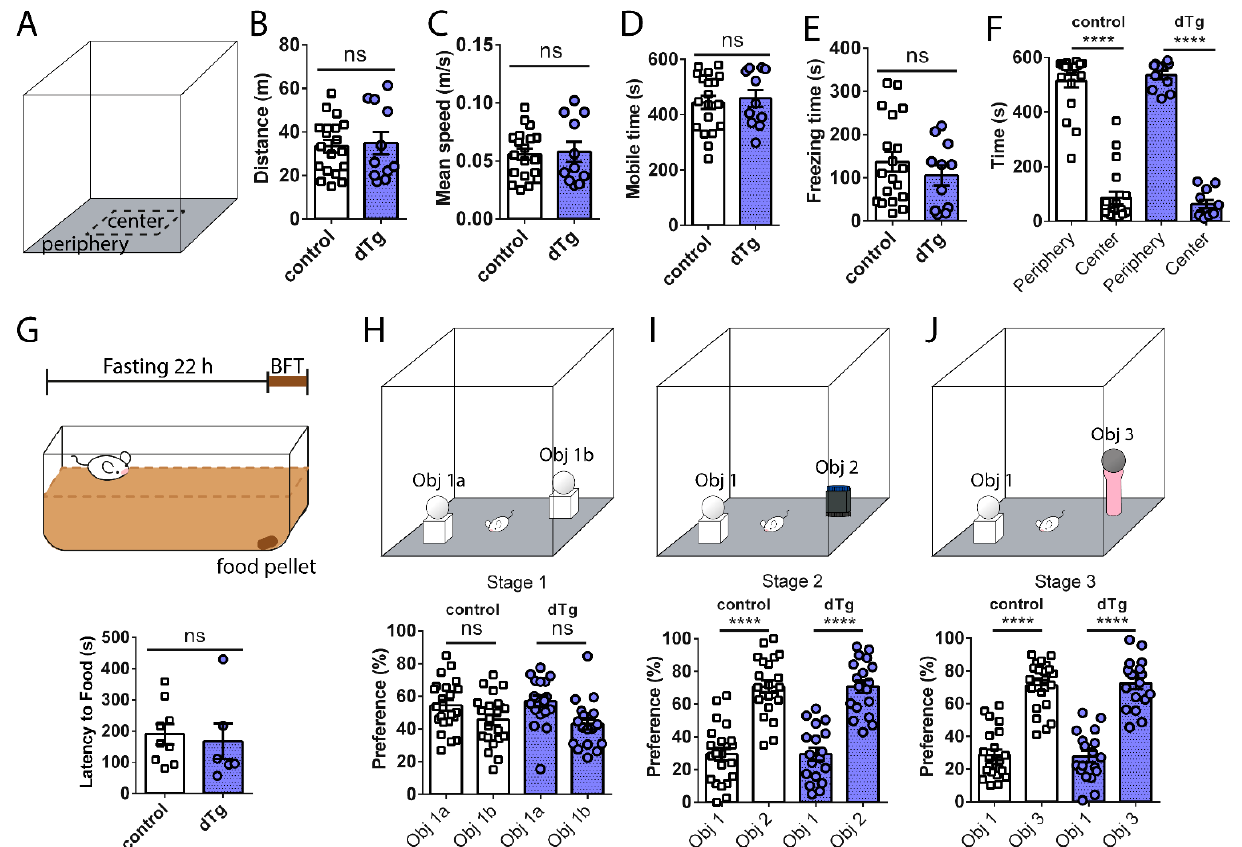
Figure 3. Normal locomotor activity, anxiety, and olfactory behavior in dTg animals. ( A ) Schematic of open field test. No differences between control and dTg mice in ( B ) distance (t (28) = 0.2464, p = 0.8072), ( C ) mean speed (t (28) = 0.2403, p = 0.8118), ( D ) mobile time (t (28) = 0.3778, p = 0.7084), ( E ) freezing time (t (28) = 0.8859, p = 0.3832), and ( F ) time spent in periphery and center zones (F (1,28) = 187.1; p < 0.0001, post hoc control p < 0.0001, dTg p < 0.0001; between genotypes F (1,28) = 0.005496; p = 0.9414, post hoc p = 0.7674, control n = 19, dTg n = 11). ( G ) Schematic of buried food test; no differences between genotypes in olfaction (t (13) = 0.3735, p = 0.7148; control n = 9, dTg n = 6). ( H – J top) Schematic of novel object recognition test. ( H ) No preference during stage 1 of the novel object recognition (F (1,38) = 5.387; p = 0.0258, post hoc control p = 0.1841, dTg p = 0.1244; between genotypes F (1,38) = 41.57; p < 0.0001, post hoc p = 0.8513; control n = 22, dTg n = 18). No difference in novelty preference, as determined by ( I ) stage 2 (F (1,38) = 56.54; p < 0.0001, post hoc control p < 0.0001, dTg p < 0.0001; between genotypes F (1,38) = 0.1587; p = 0.6926, post hoc p = 0.9997), and ( J ) stage 3 (F (1,38) = 84.13; p < 0.0001, post hoc control p < 0.0001, dTg p < 0.0001; between genotypes F (1,38) = 2.613; p = 0.1143, post hoc p = 0.9652), of the novel object recognition. dTg, double transgenic; BFT, buried food test; Obj, object. **** p < 0.0001, ns = no significance; two ‐ tailed unpaired t ‐ test for two group comparisons and two ‐ way RM ANOVA followed by post hoc Holm–Sidak comparisons for more than two groups. Data are expressed as mean ± SEM. n = number of mice.